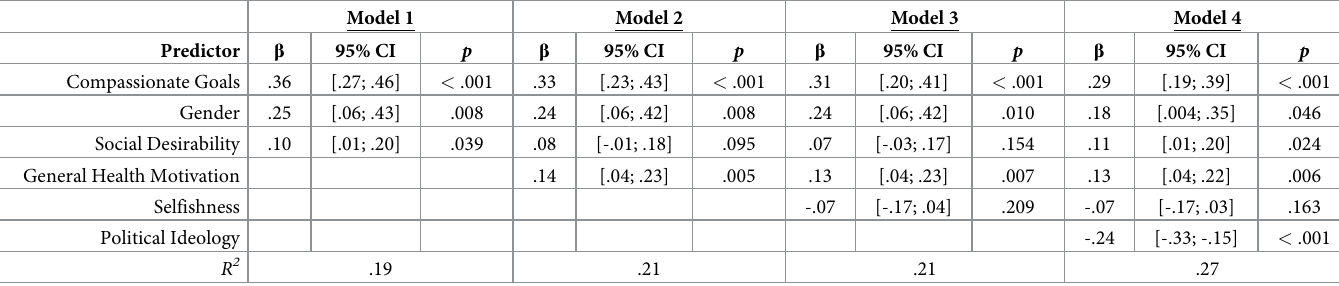
Table 6. Coefficients from multiple regression models predicting COVID-19 health behaviors in Study 2. Model 1